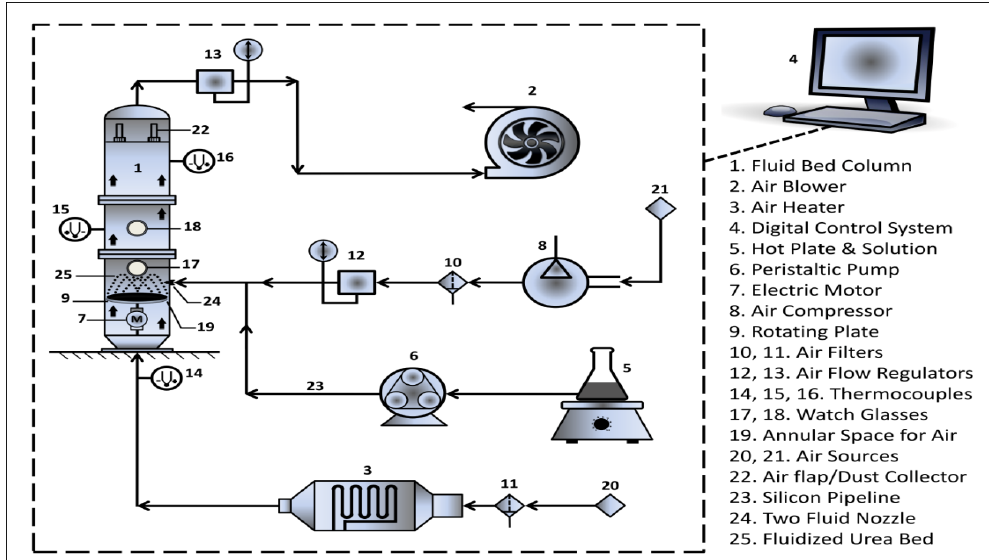
Figure 1. Schematic arrangement of rotary fluidized bed equipment for St-PCU production